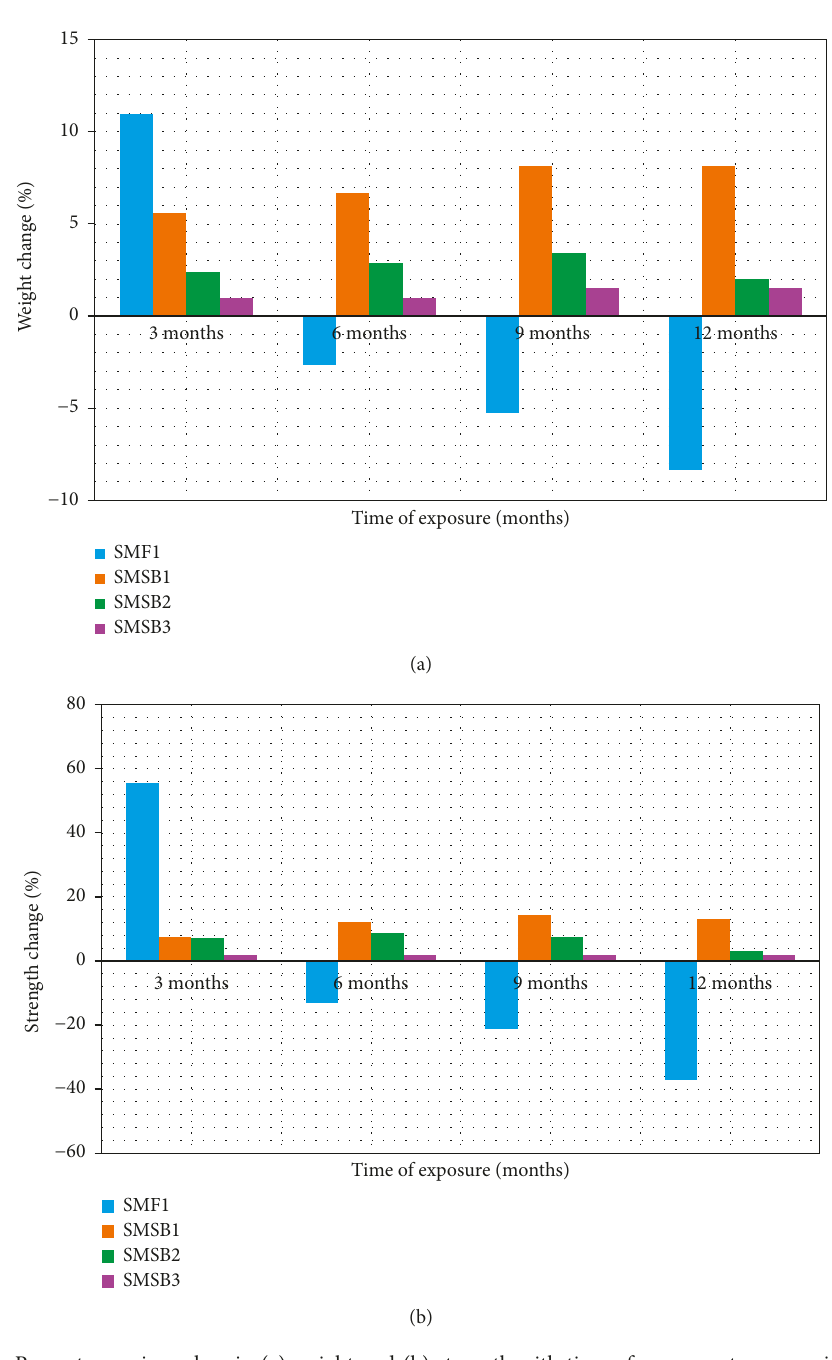
Figure 11: Percentage gain or loss in (a) weight and (b) strength with time of exposure to magnesium